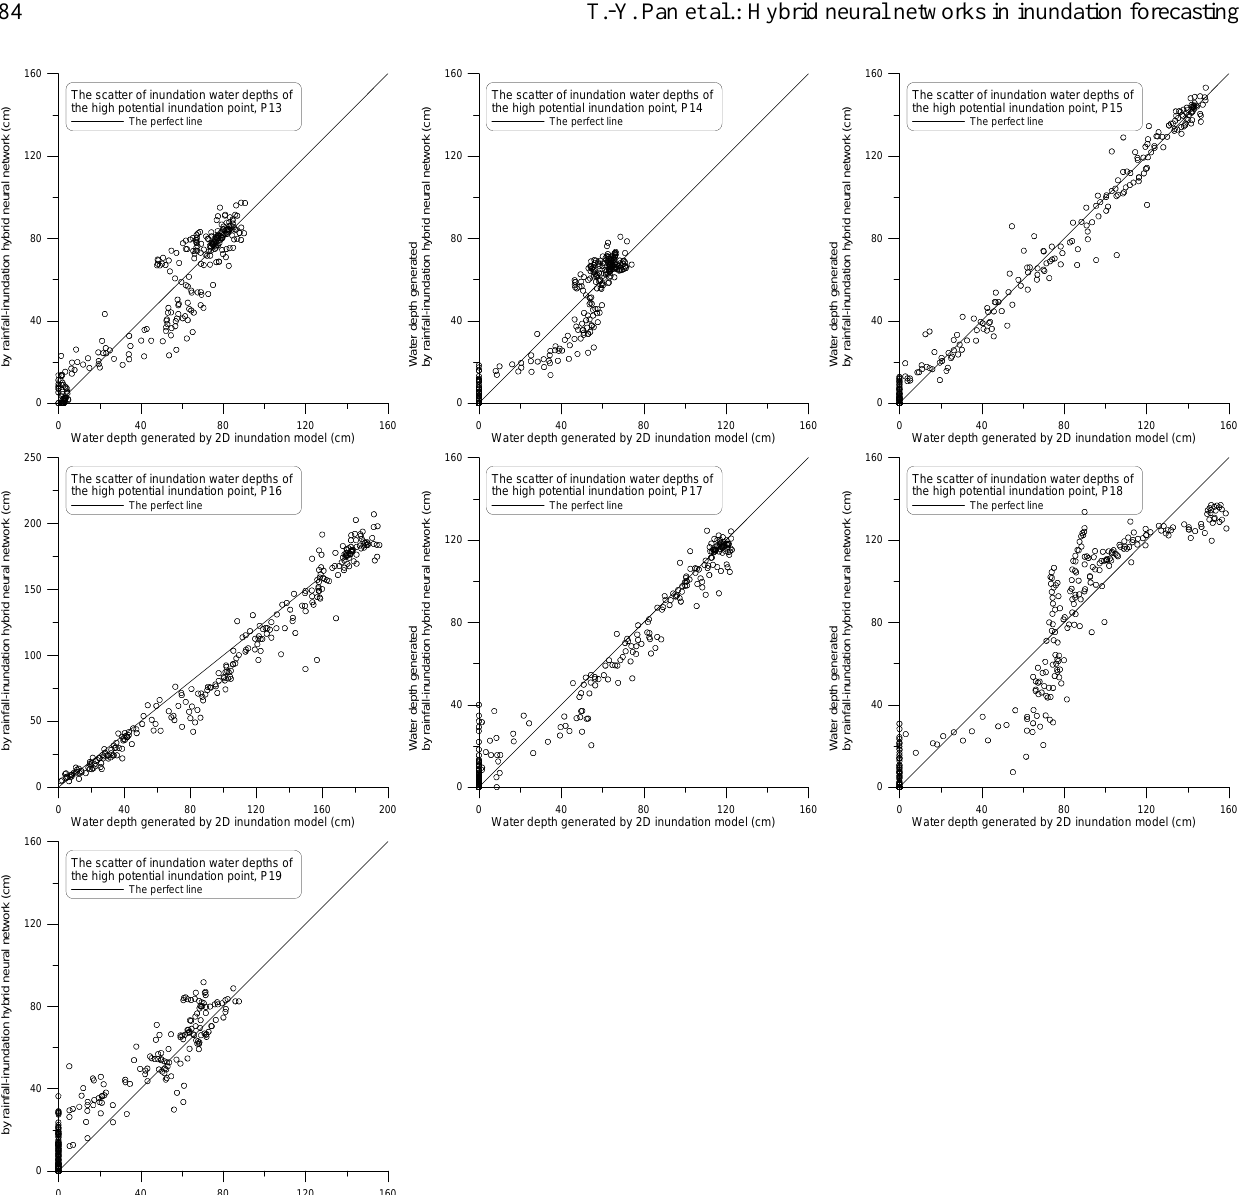
Fig. 9. The scatter plots of the forecast by RiHNN (Model D) and the synthetic inundation by 2-D overland-flow model for the P13 ∼ P19 representative inundation locations. the capability of RiHNNs has been examined through four types of real/synthetic rainfall events, and the performance of rainfall-inundation forecasting via RiHNNs has been eval- uated by five criteria. These evaluations reveal that RiHNNs not only forecast inundation depths more accurately for the event with design hyetograph pattern, but also fit inundation- depth hydrographs with higher rainfall